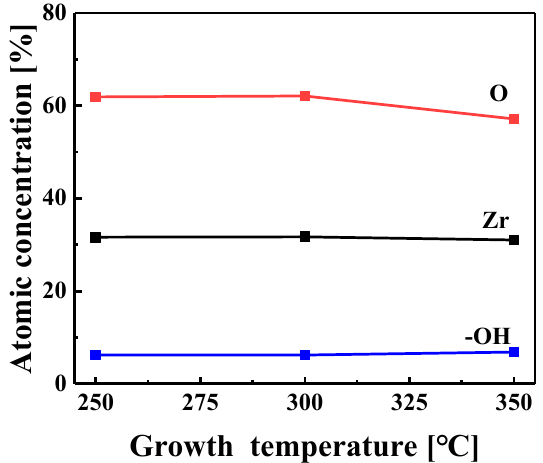
Figure 2. Compositions of ZrO 2 films grown at different temperatures.